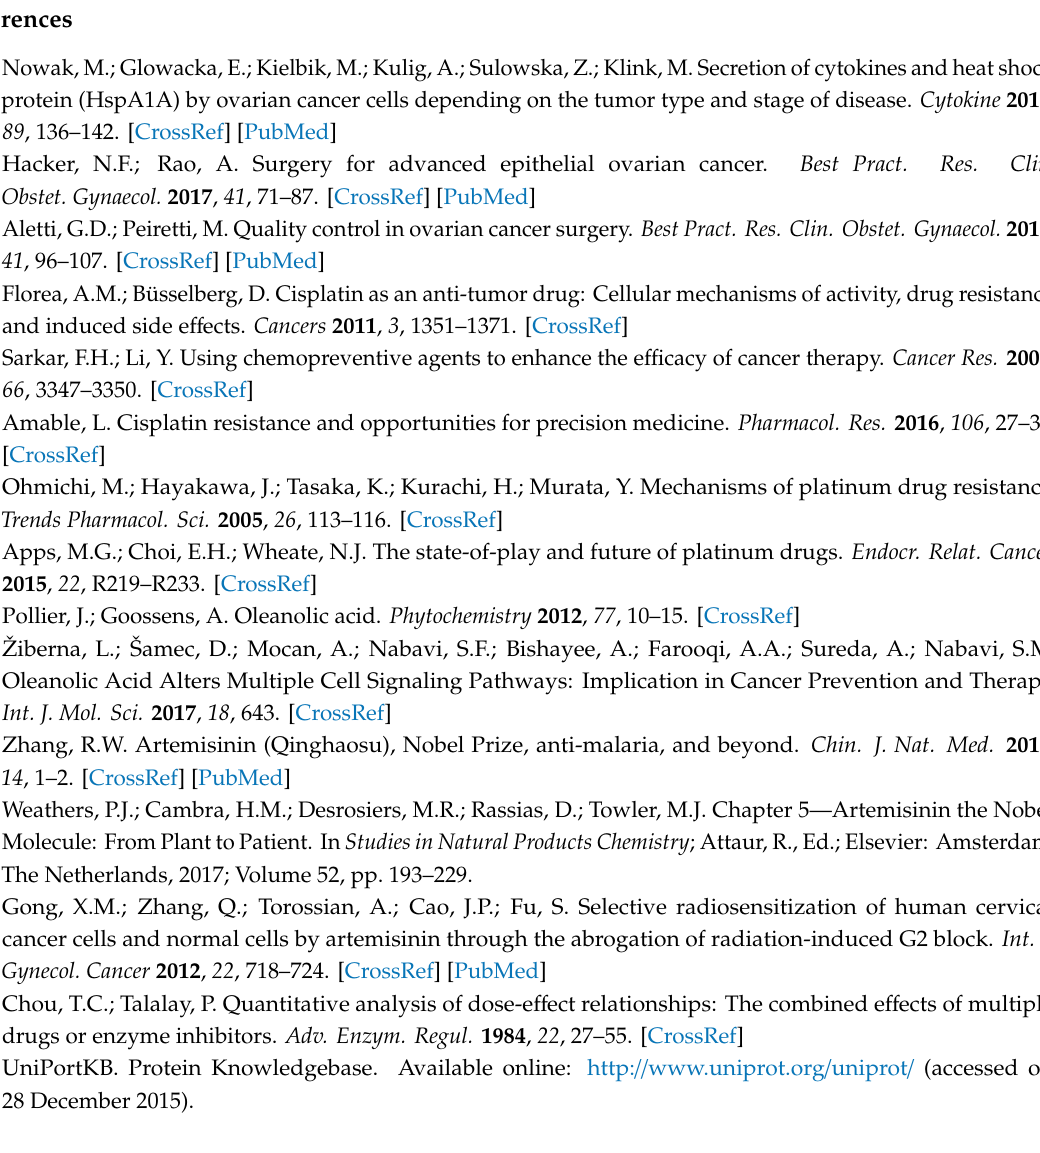
Table S1, Video S1: Characteristics of proteins that have undergone di ff erential expressions in A2780 and A2780cisR cell lines following treatment with selected drug combinations using A2780 cell line as